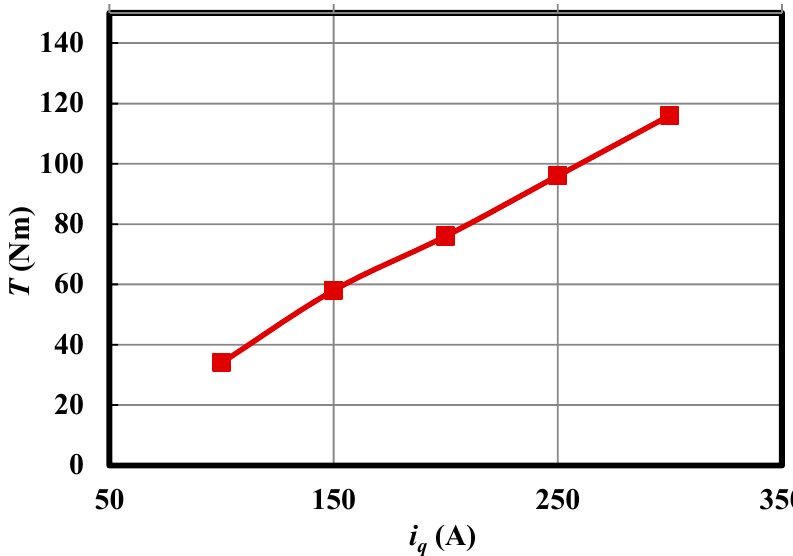
Figure 22. WFSM torque versus q -axis current i q at 2000 r/min.